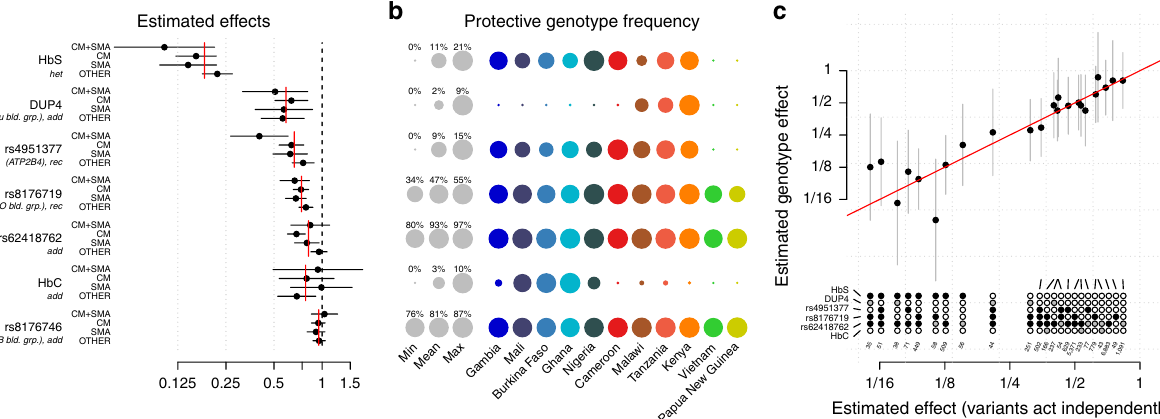
Fig. 4 A joint model for natural genetic resistance to malaria. a Effect sizes for severe malaria subtypes are estimated in a joint model, which includes the fi ve replicating associated variants and two additional variants (rs33930165, which encodes haemoglobin C, and rs8176746, which re fl ects the A/B blood group) in associated regions. The model was fi t across all 11 populations, assuming the effect on each phenotype is fi xed across populations, and including a population indicator and fi ve principal components in each population as covariates. Each variant is encoded according to the mode of inheritance of the protective allele inferred from discovery analysis. Red lines indicate the overall effect across severe malaria subtypes, computed as an inverse variance- weighted mean of the per-phenotype estimates. Only cases with positive measured falciparum parasitaemia were included in model fi t. b The frequency of the protective allele (for effects inferred as additive) or protective genotype (for non-additive effects) of each variant in each population. Grey circles depict the minimum, mean and maximum observed frequencies across populations. Coloured circles re fl ect the per-population frequencies. Frequency estimates are computed using control samples only. c Comparison of effect-size estimates against severe malaria for combinations of genotypes (stacked circles) carried by at least 25 study individuals, across the top six variants in a . Black fi lled and open circles denote the protective and risk dosage at the corresponding variant, respectively; grey circles denote heterozygote genotype for variants with inferred additive effect. Effect-size estimates are computed using the model as in a assuming independent effects (x axis), or jointly allowing each genotype its own effect (y axis). Source data are provided as a Source Data fi